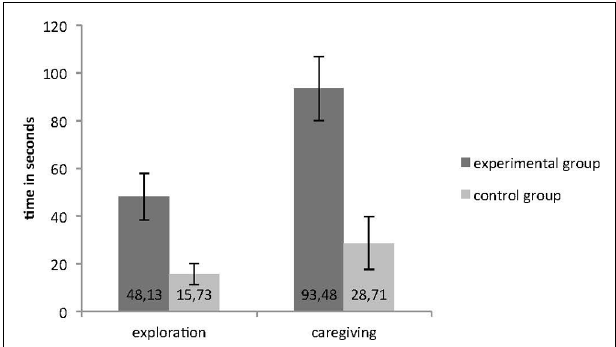
FIGURE 2 |Time in seconds spent by the participants of the two groups in object exploration and caregiving with error bars representing standard